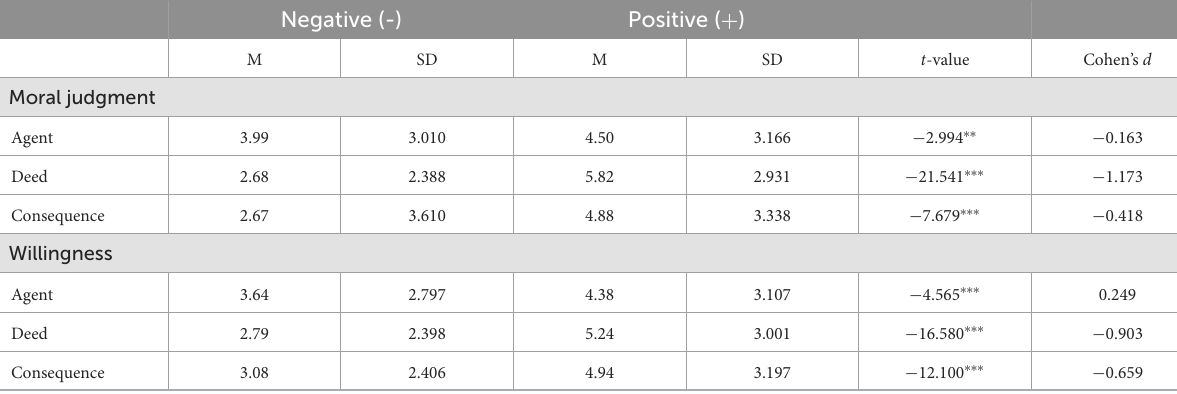
TABLE 2 Bivariate treatment effects ( N = 1,349).